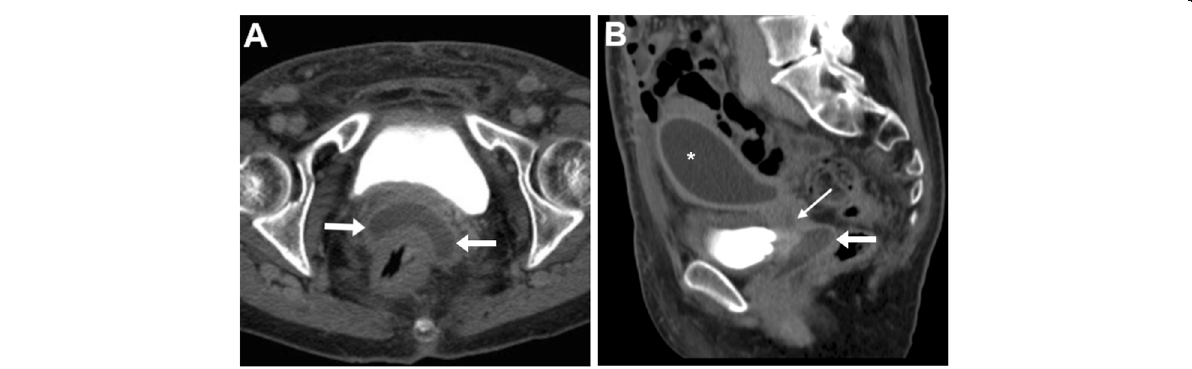
Fig. 17 Differential diagnosis: rare case of lymphatic VF in a 67-year-old with previous laparotomic surgery for advanced ovarian cancer. CT ( a , b ) shows fluid-filled dilatation of the vagina (arrows) communicating via a fistula (thin arrow in b ) with an ovoid fluid-attenuation pelvic collection (* in b ) consistent with postoperative